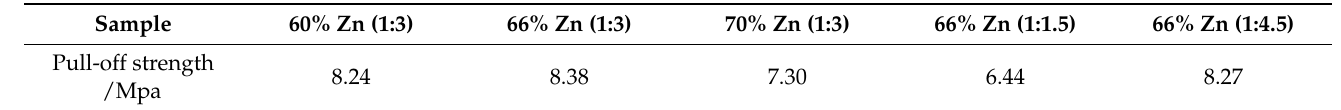
Table 3. The pull-off strengths of ZRP coatings with different zinc content and replacing ratios of conductive PPy/SCP